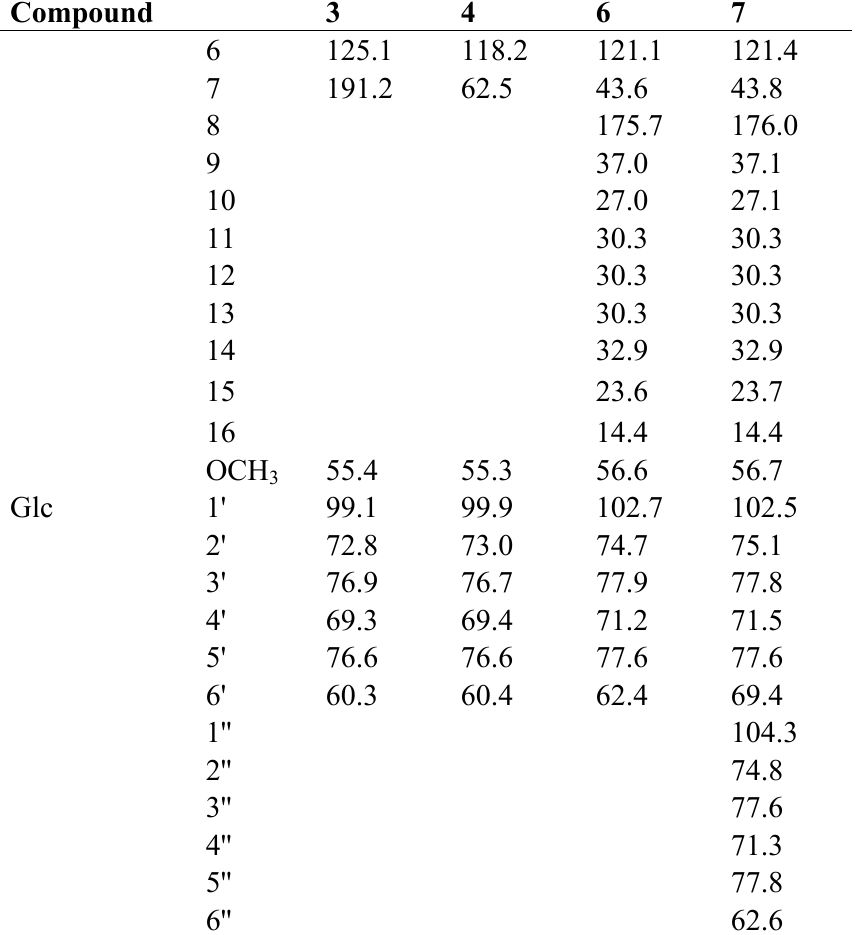
Figure 1. Time course of the biotransformation of vanillin ( 1 ) by cultured cells of E. perriniana . Yields of 1 ( ■ ), 2 ( ○ ), 3 ( ● ), and 4 ( ▲ ) are